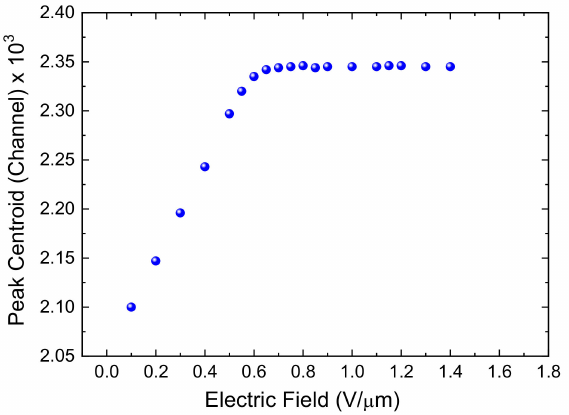
Figure 8. Peak centroid vs. external electric field for a 500 µ m thick SCD diamond irradiated with 5.5 MeV alphas from 241